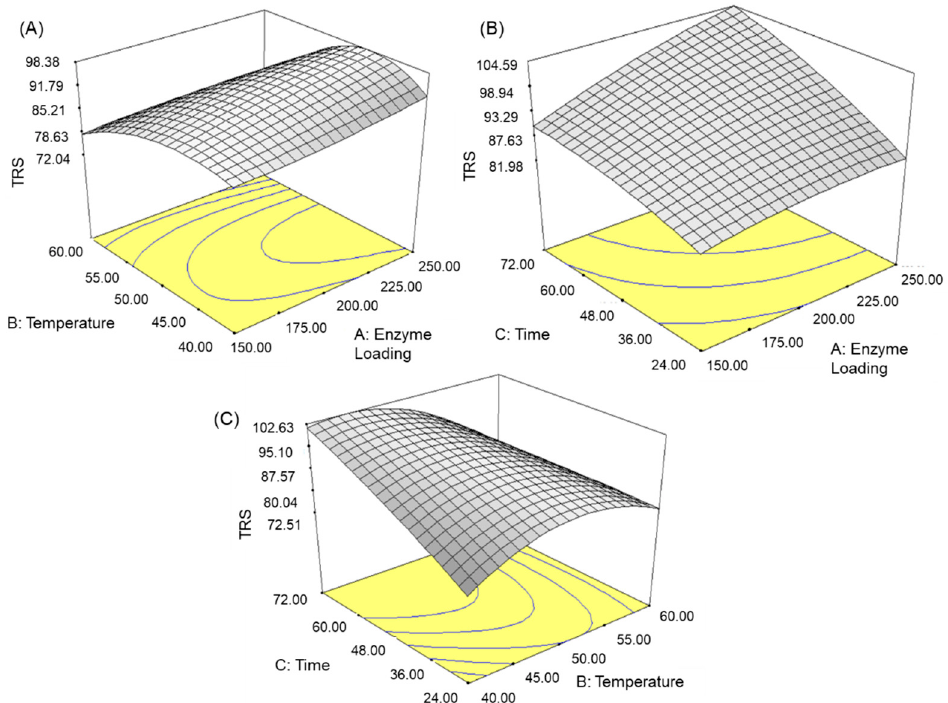
Figure 3. The surface response plots depict the effects of enzyme loading, temperature, and time of the hydrolysis process on the TRS yield amount. The surface response plots were obtained with ( A ) a constant time of 48 h, ( B ) a constant temperature of 50 °C, and ( C ) a constant enzyme loading of ( A ) a constant time of 48 h, ( B ) a constant temperature of 50 ◦ C, and ( C ) a constant enzyme loading of 20.0 µg/g. 20.0 µ